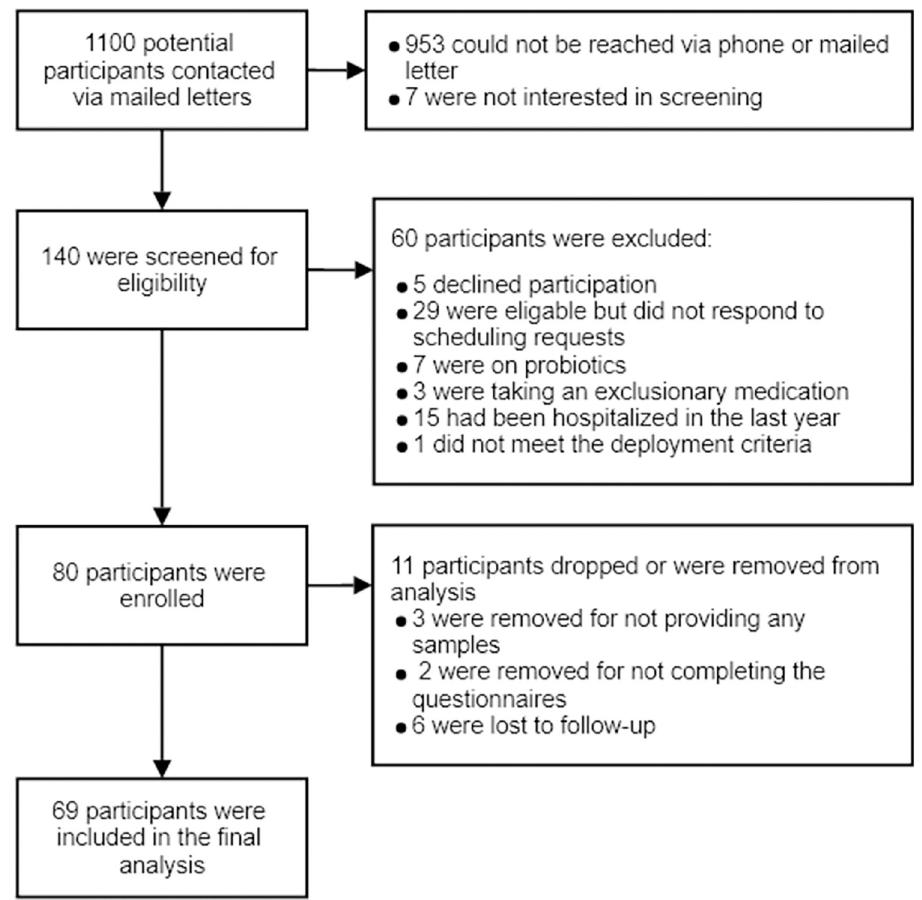
Fig 1. Flowchart of study enrollment. Note: The database providing contact information for the 1100 Veterans provided mailing addresses for all Veterans aged 43–75 deployed to the Persian Gulf as part of Operation Desert Storm/Desert Shield between 1990 and 1991 who lived in our catchmant area. This was not a clean dataset with many Veterans having multiple addresses listed, addresses that were not current, addresses for Veterans who no longer live in our catchment area, and addresses that were innacurately recorded. This lead to needing to mail a large number of letters to reach a small number of Veterans.